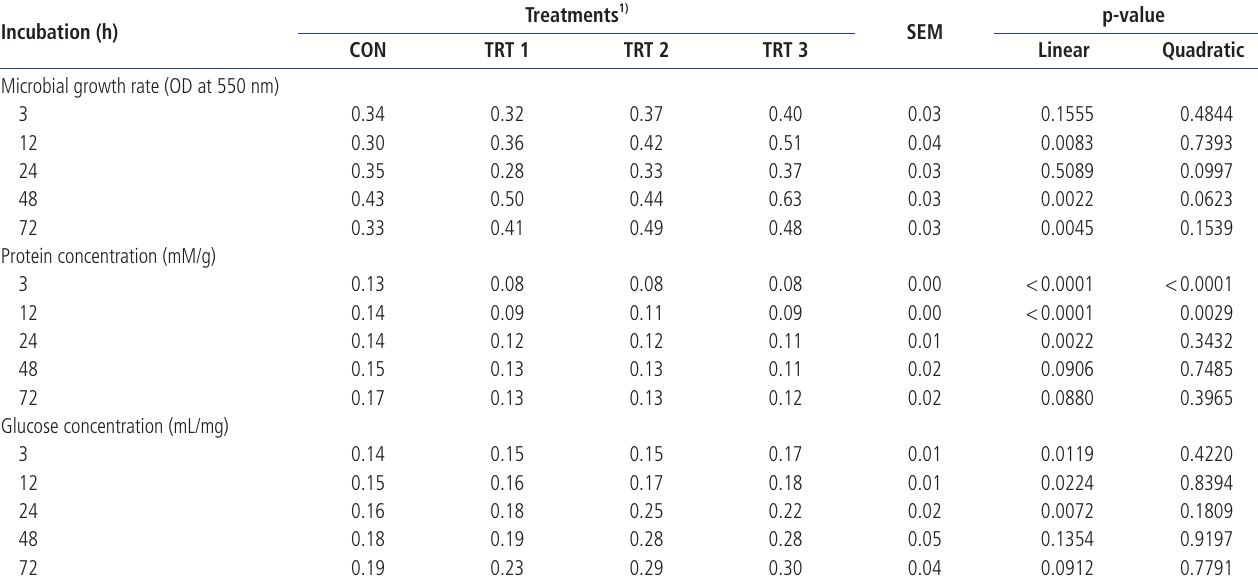
Table 5. Effect of Gelidium amansii on rumen microbial growth rate, protein and glucose concentration Incubation